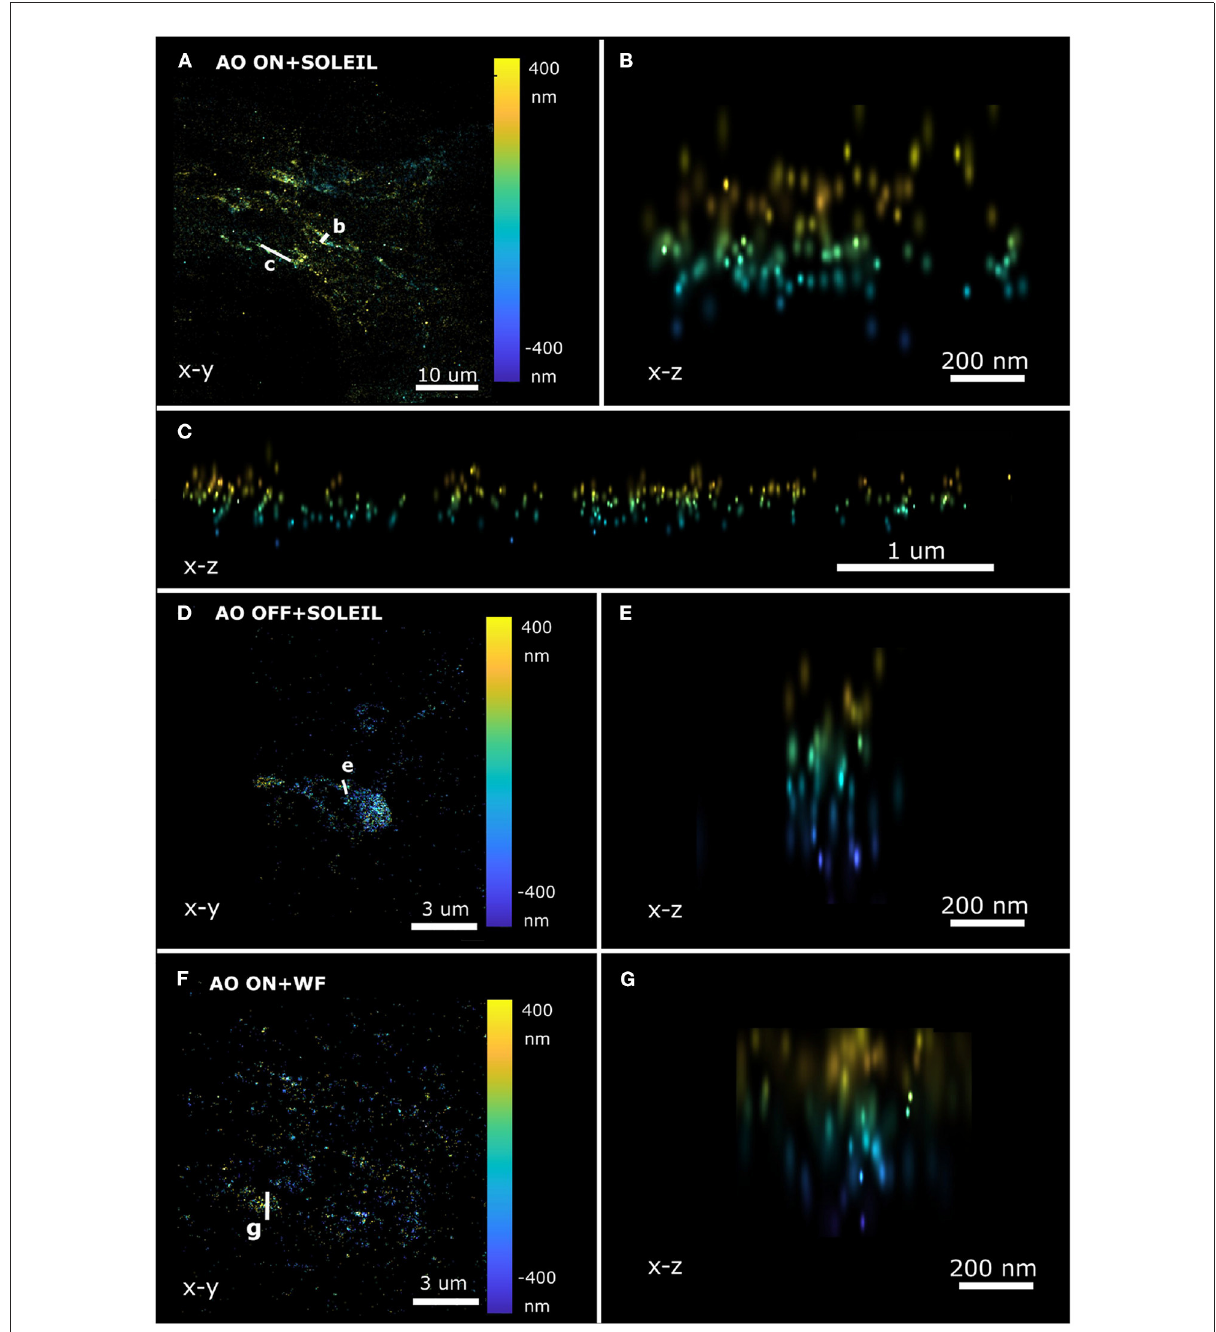
FIGURE14 Axial SMLM reconstruction cross-section of a single neuron in a whole adult Drosophila brain. (A–C) SOLEIL illumination with AO correction. (A) Lateral view and axial cross-section (B,C) . (D,E) SOLEIL illumination without AO correction. (D) Lateral view and (E) axial cross-section. (F,G) Widefield illumination with AO correction. (F) Lateral view and (G) axial cross-section.